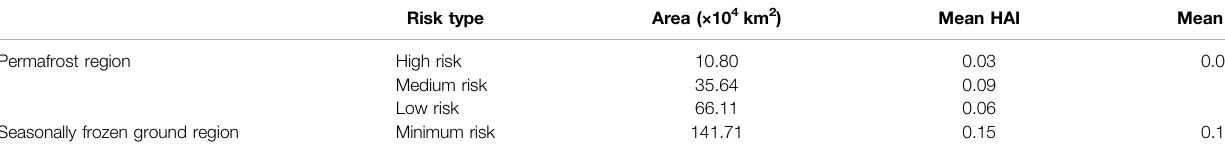
TABLE 4 | Mean human activity intensity (HAI) in different thaw settlement risk regions of frozen ground in